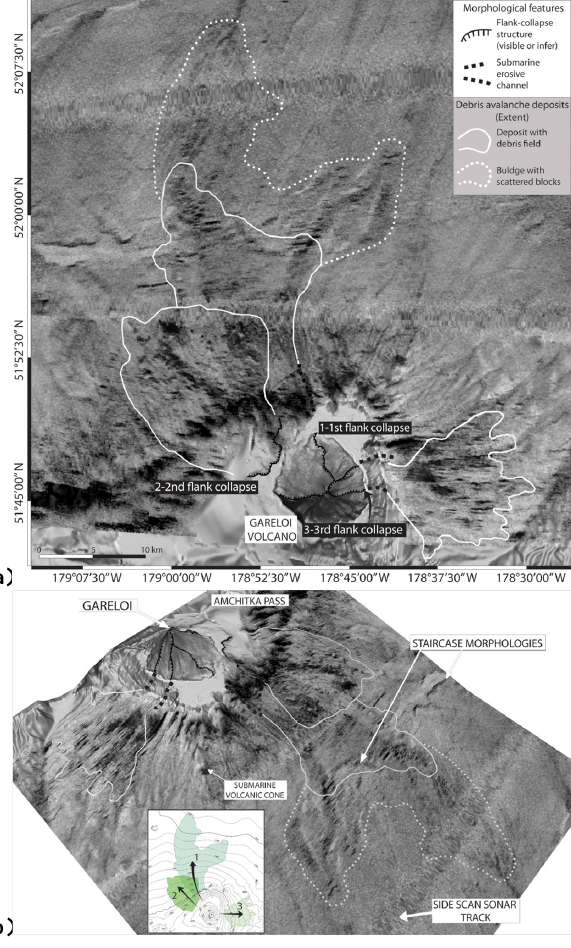
Fig. 6. (a) Plan view: topography, bathymetry and Gloria side-scan data of Gareloi island. The image displays the three deposits sur- rounding the volcano. Also visible are arcuate crests and staircase morphologies on the NNW. (b) 3-D view. For side scan data the black is high backscatter and white is low